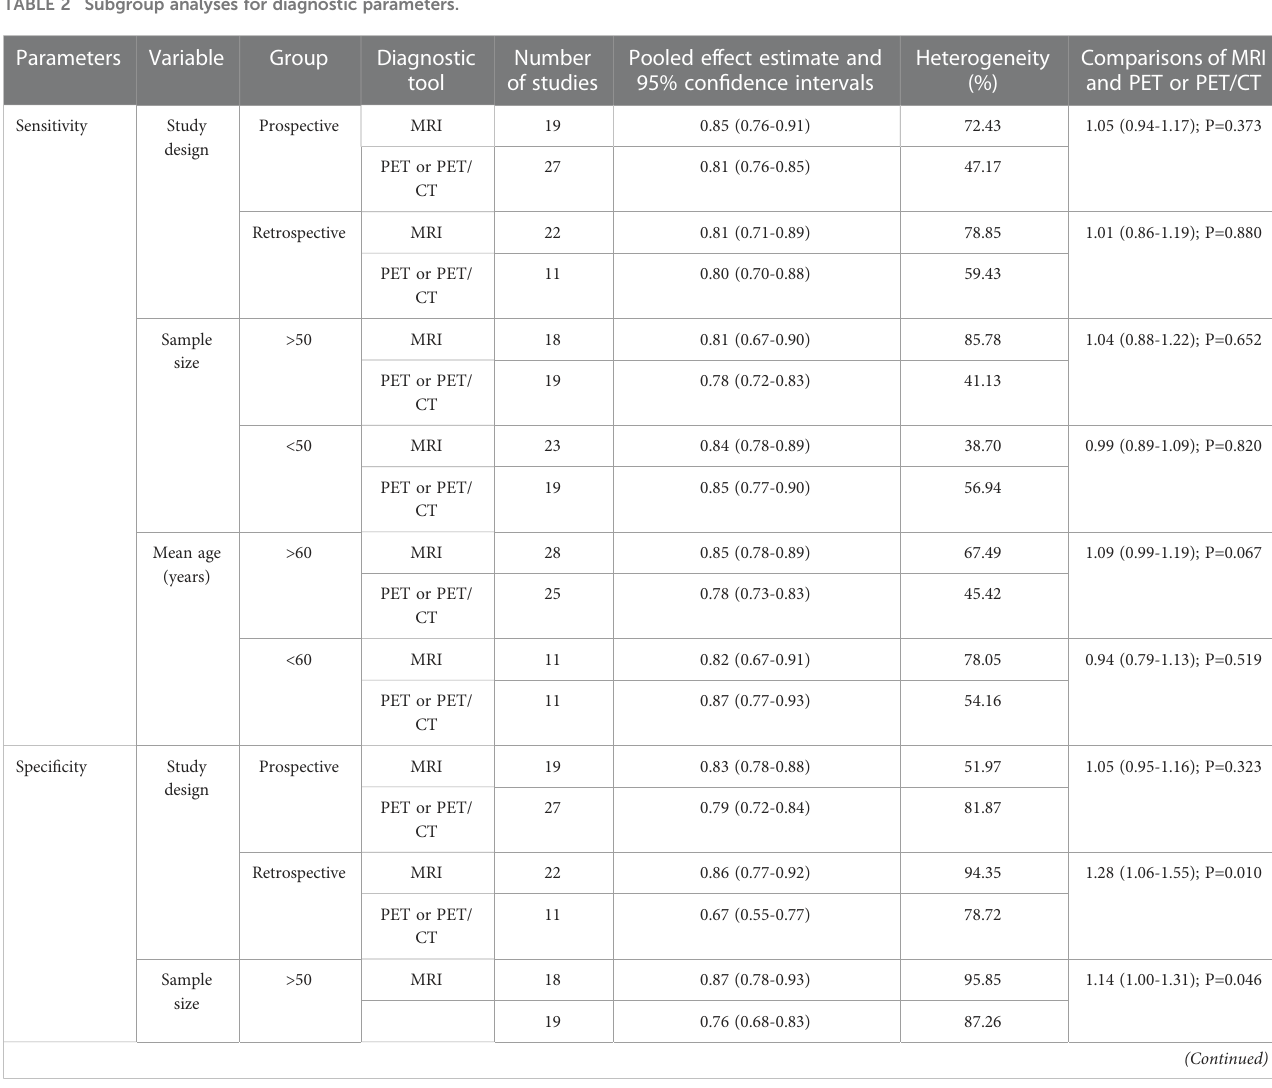
Number Pooled effect estimate and tool of studies 95% con fi dence intervals